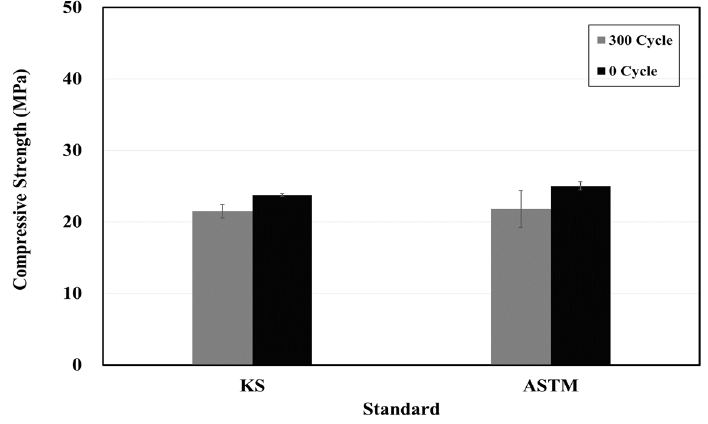
Figure 7. Compressive strength test results based on the KS and ASTM standards at the 0th and 300th freezing–thawing cycles.